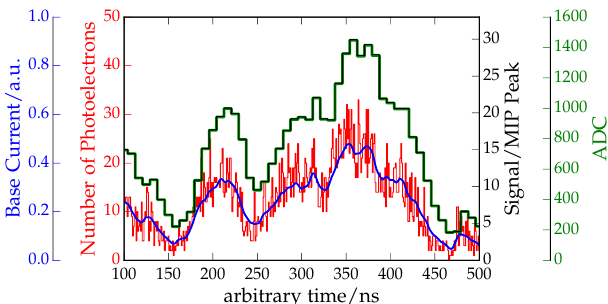
Figure 5. Simulated SSD measurement. Time traces for PE pro- duction, current at the base of the PMT, post-electronics digitized signals, and calibrated to the signal of one Vertical Minimum Ionizing Particle (VMIP) are